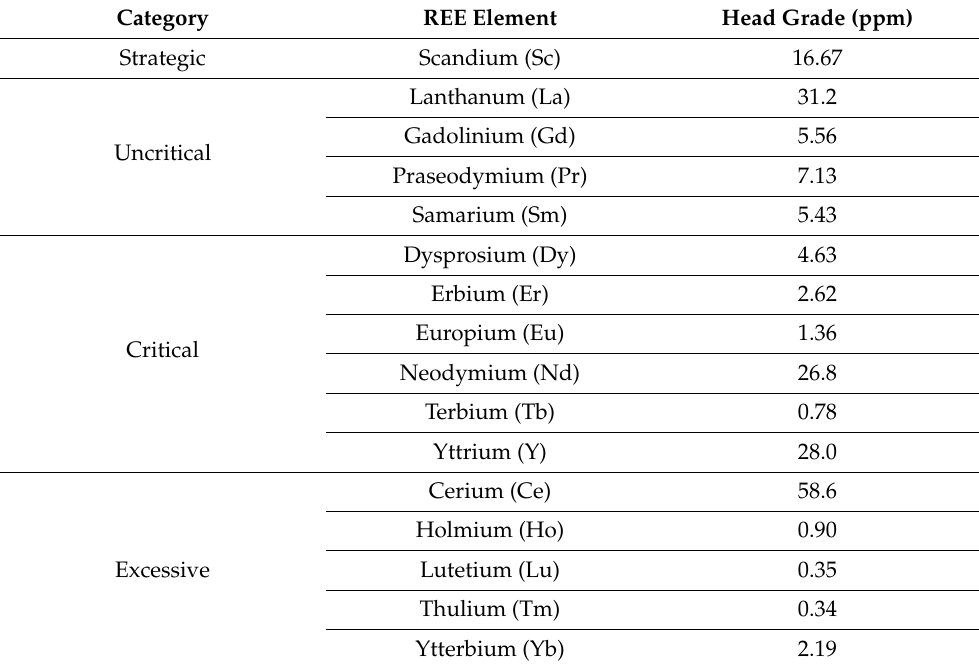
Table 3. Relative abundance of REEs in the